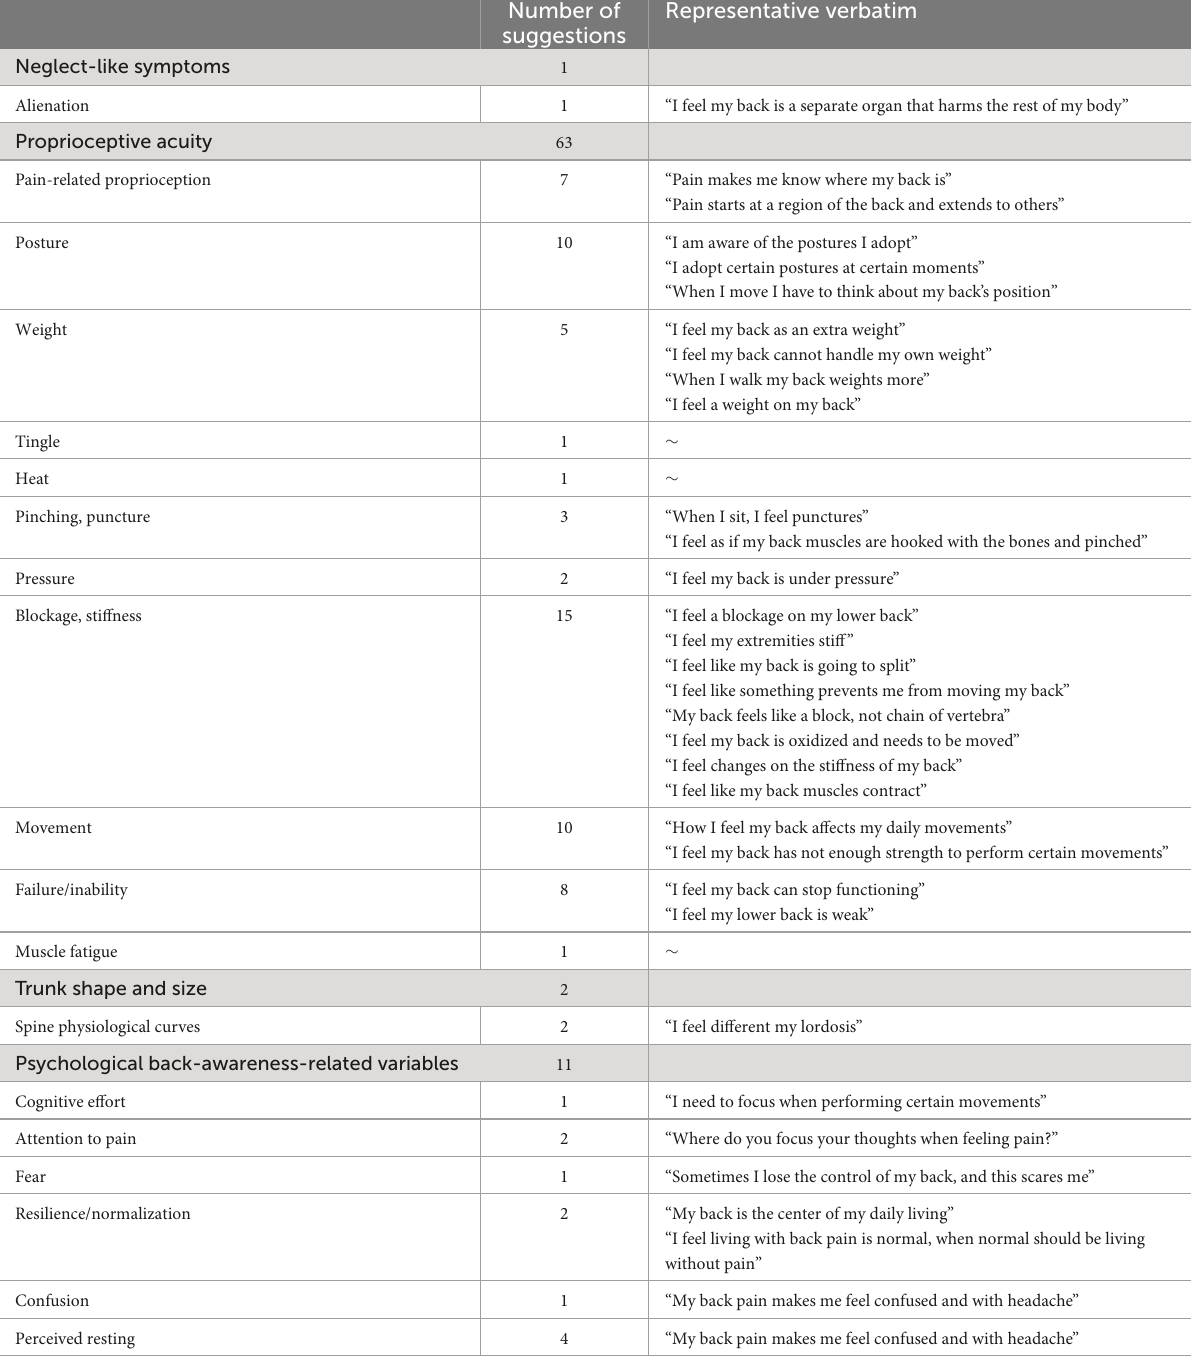
TABLE 3 Variables suggested to be related to back awareness by the chronic low back pain group.